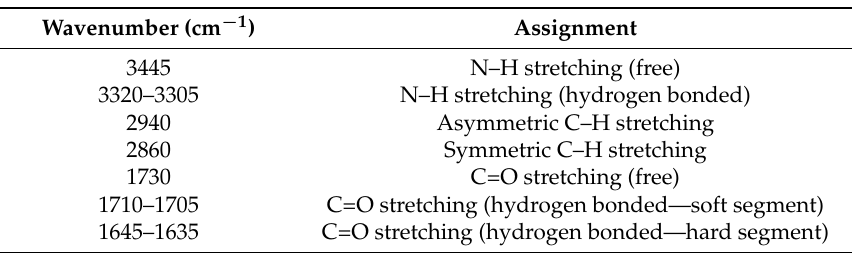
Table 2. Major infrared bands of PUs.